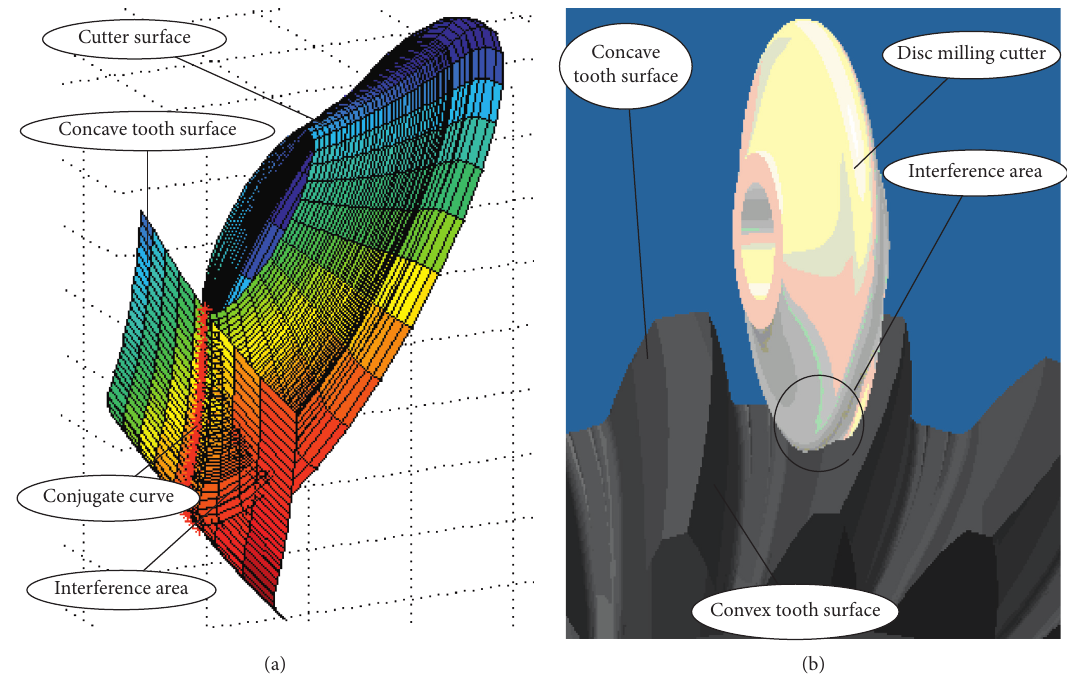
Figure 7: Interference between disc milling cutter and theoretical tooth surface. (a) Precise modeling drawing. (b) Three-dimensional schematic